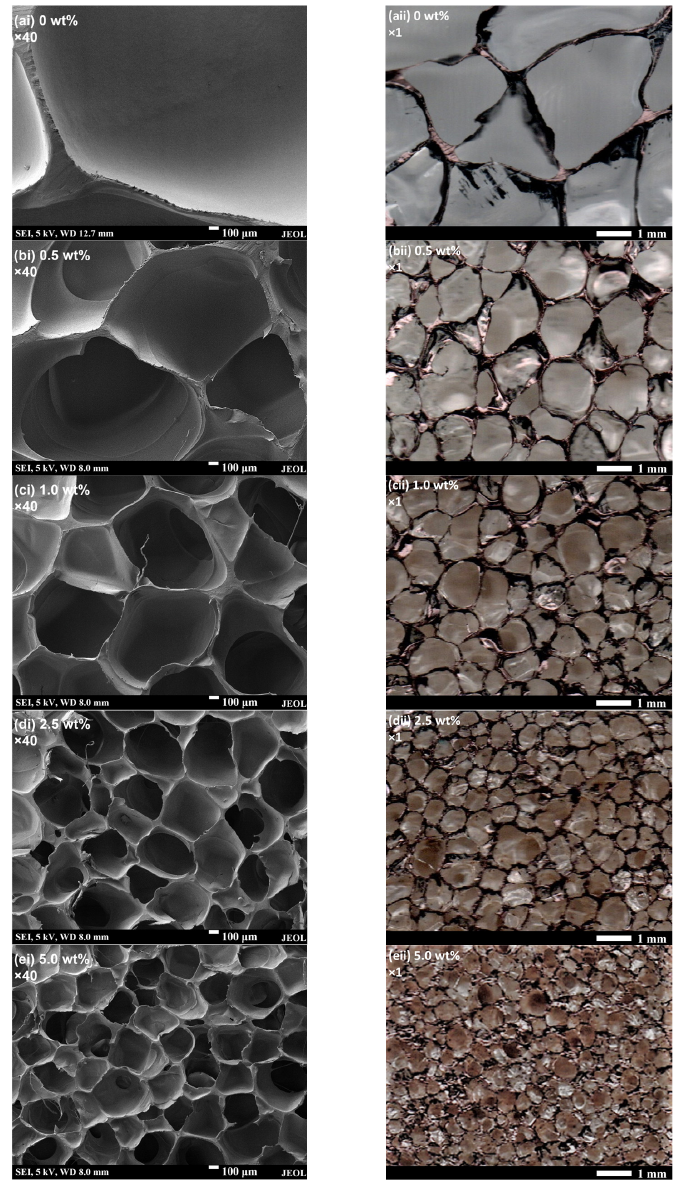
Figure 5. ( i ) SEM and ( ii ) optical cross-sectional images of the ( a ) PP and PP/lignin composite foams with ( b ) 0.5, ( c ) 1, ( d ) 2.5, and ( e ) 5 wt% lignin loading showing the foam morphologies.